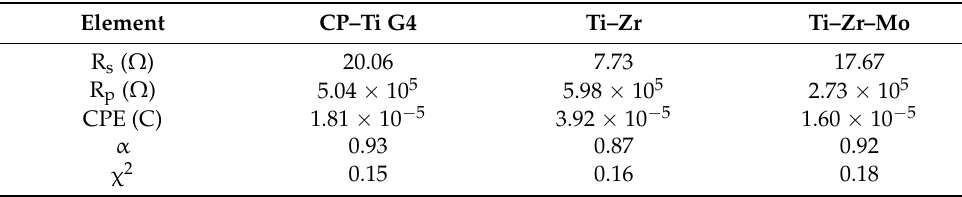
Table 4. Electrochemical and tribological parameters, obtained from the potentiodynamic polariza ‐ tion curves of the alloys studied in PBS.